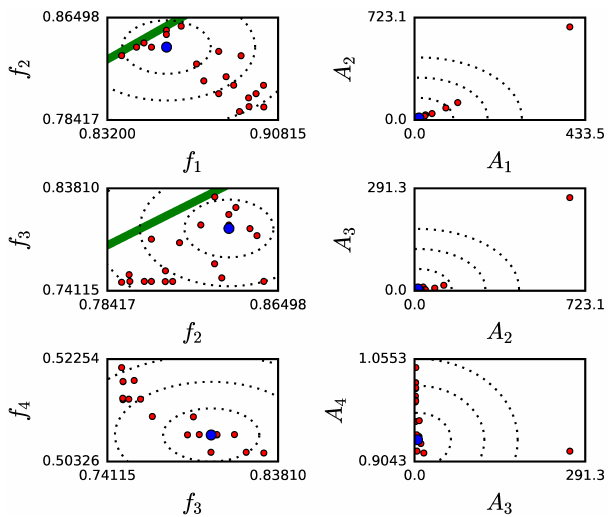
Fig. 7.— Model 27 frequencies ( f 1 ,f 2 ,f 3 ,f 4 ) and amplitudes ( A 1 ,A 2 ,A 3 ,A 4 ) for Table 3 data. Otherwise as in Fig.